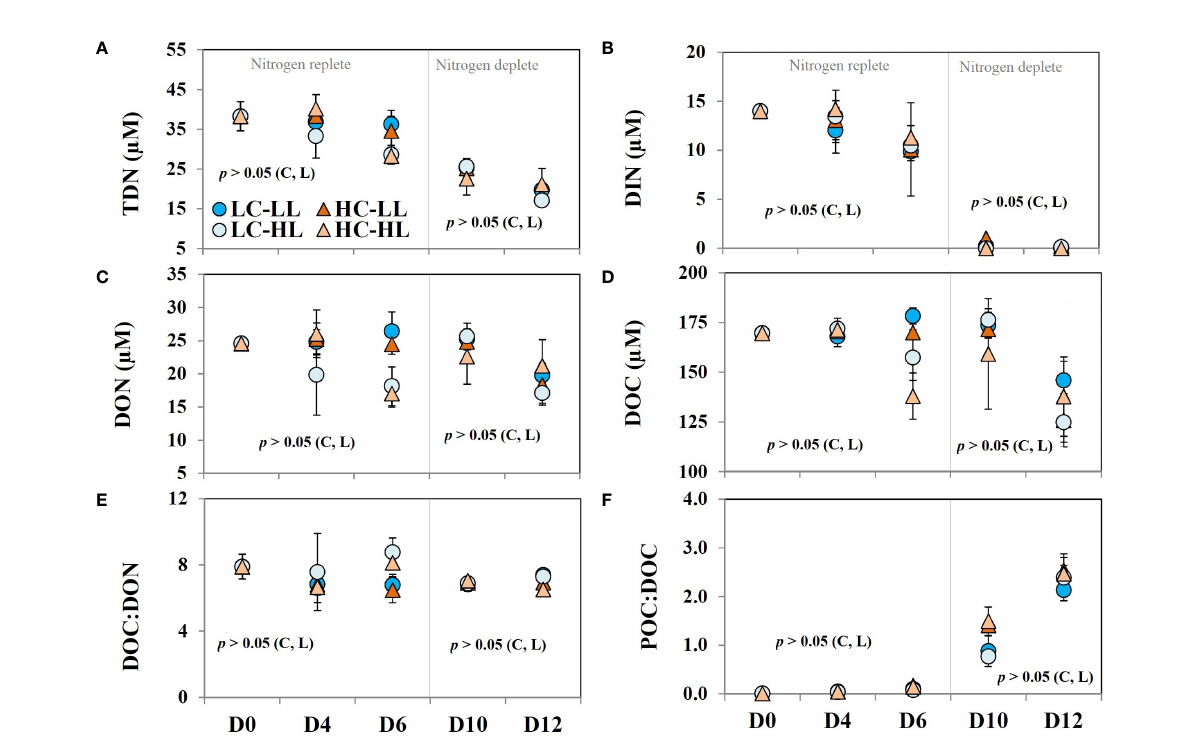
FIGURE 4 (A) total dissolved nitrogen (TDN) contents; (B) dissolved inorganic nitrogen (DIN) contents; (C) dissolved organic nitrogen (DON); (D) dissolved organic carbon contents (DOC); (E) the ratio of DOC : DON; (F) the ratio of POC : DOC over the experimental period under two different light conditions [low light (LL) = 50 µmol m -2 s -1 , high light (HL) =100 µmol m -2 s -1 ] and CO 2 levels [low CO 2 (LC) ≈ 240 µatm and high CO 2 (HC) ≈ 900 µatm levels] (n =3; ± SD). The level of signi fi cance ( p -values) related to CO 2 and light levels are shown as C and L, respectively. The gray line demarcates the nitrogen replete and deplete